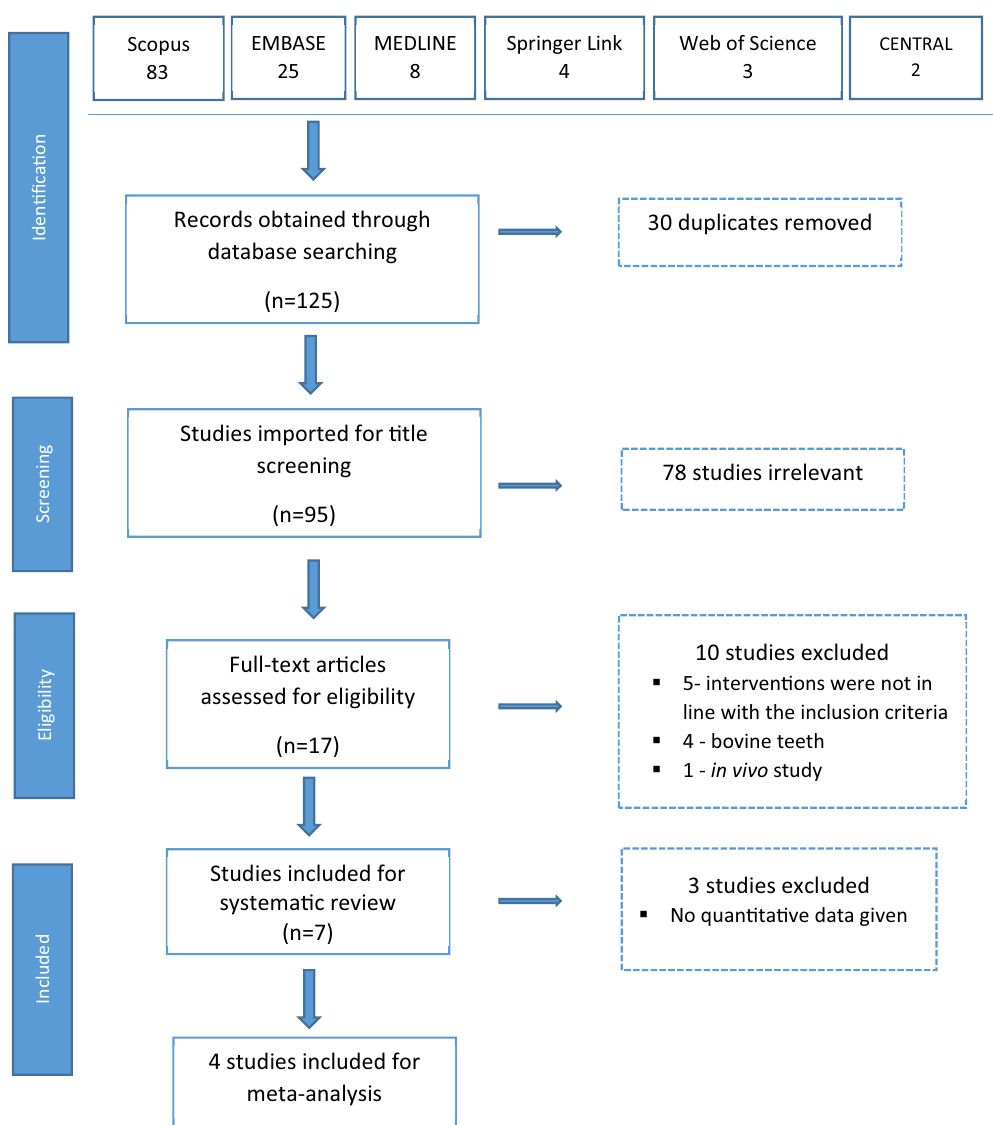
Figure 1. Flow chart of steps in literature